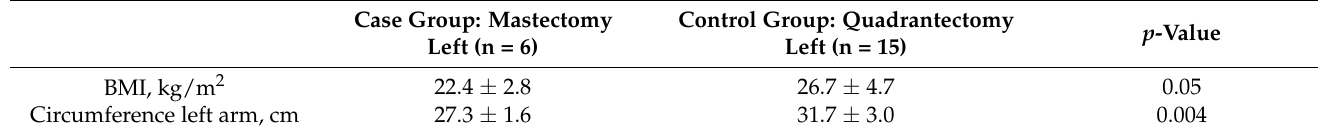
Table 2. Body composition «of side» in patients with mastectomy vs. patients with quadrantectomy. Case Group: